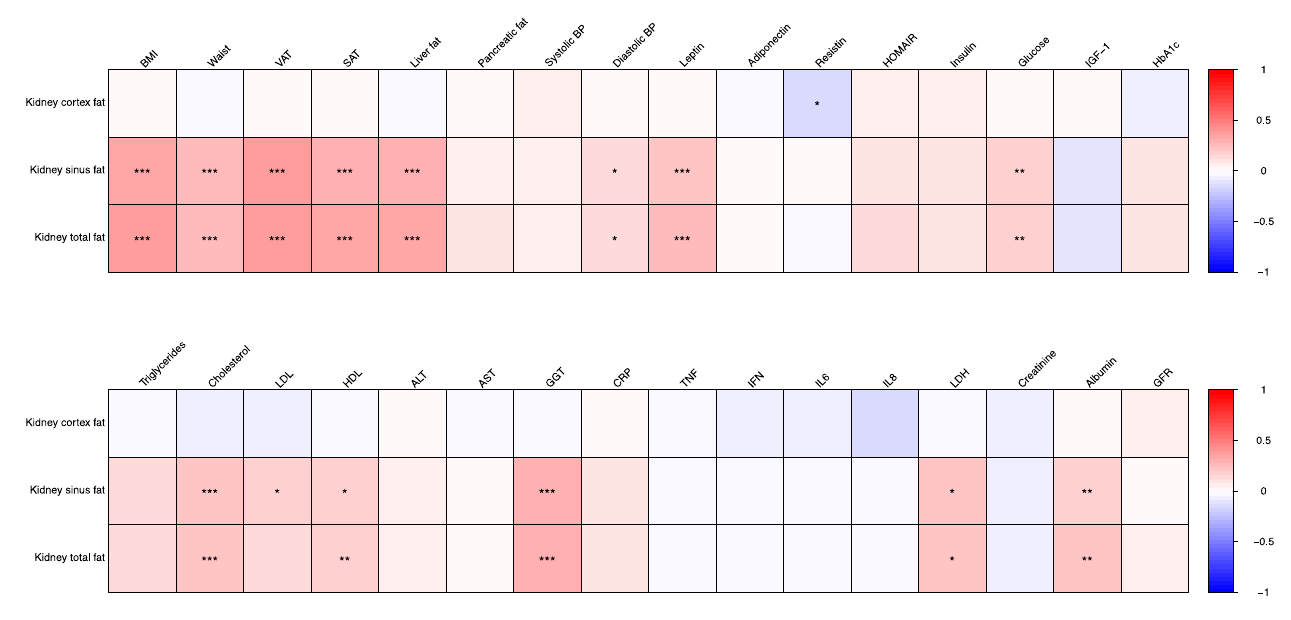
Figure 1. Repeated measures correlations of kidney cortex fat, kidney sinus fat and kidney total fat over all time points (time points T0, T1, and T3 combined). The asterisks *, ** and *** represent p -values (after Bonferroni correction) of 0.05, 0.01 and 0.001, respectively. Abbreviations: LDL, low density lipoprotein, SAT, subcutaneous adipose tissue; BMI, body mass index; VAT, visceral adipose tissue, ALT, alanine aminotransferase; AST, aspartat aminotransferase, GGT, gamma glutamyl transferase, CRP, C-reactive protein, TNF, tumour necrosis factor, IFN, interferon, IL, Interleukin, LDH, lactate